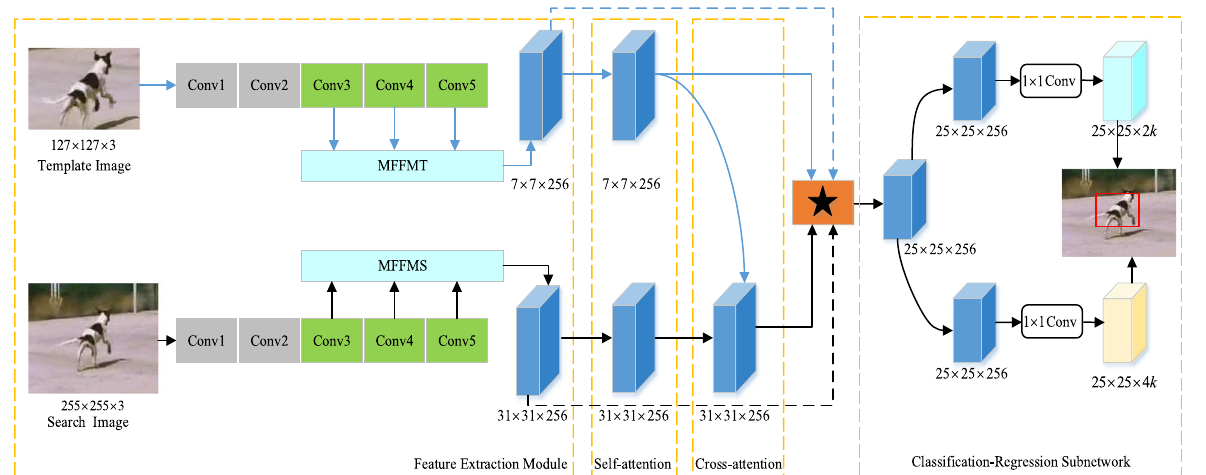
Fig. 1 Algorithm